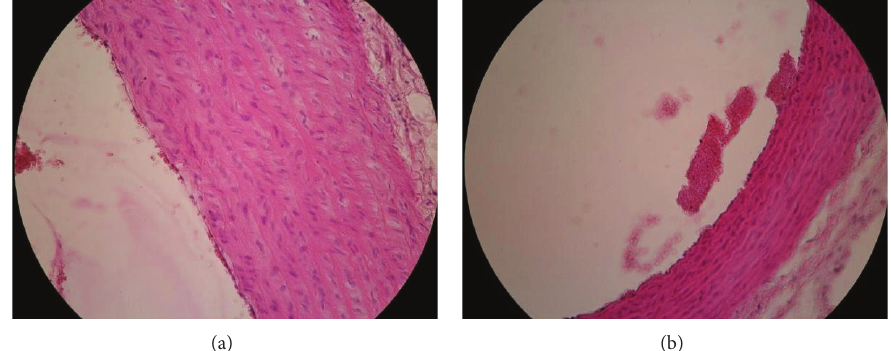
Figure 2: Aorta—Ovx + lard + flaxseed group (HE staining × 20). (a) Isolated adherent platelets. (b) Rare adherent platelets.